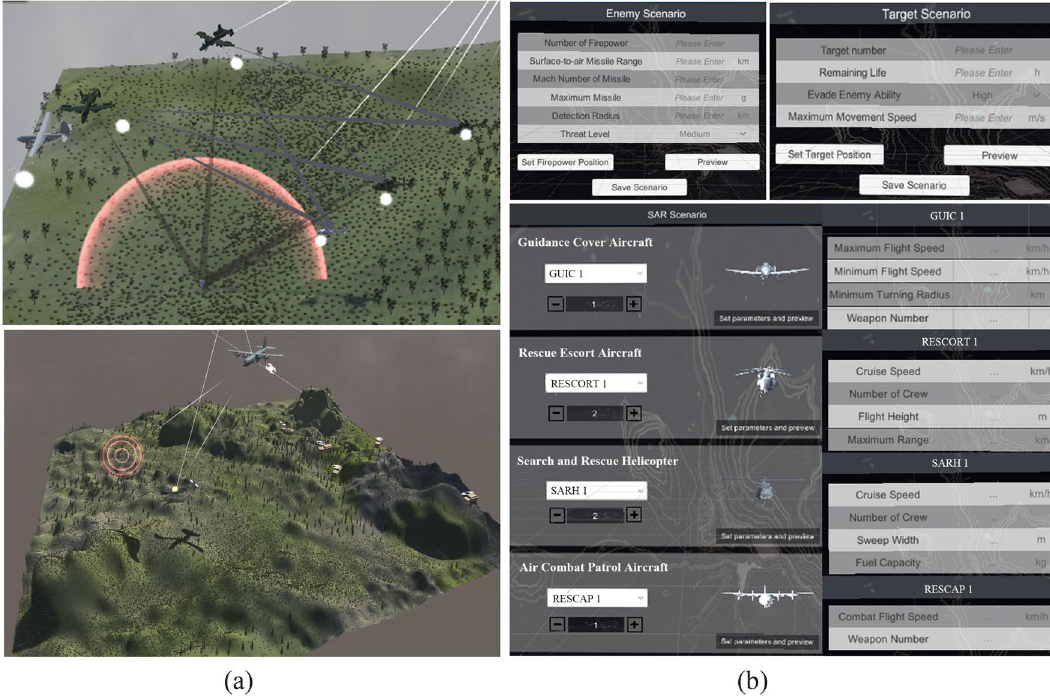
Figure 8. The SAR scenario, scenario editing and parameter setting module.